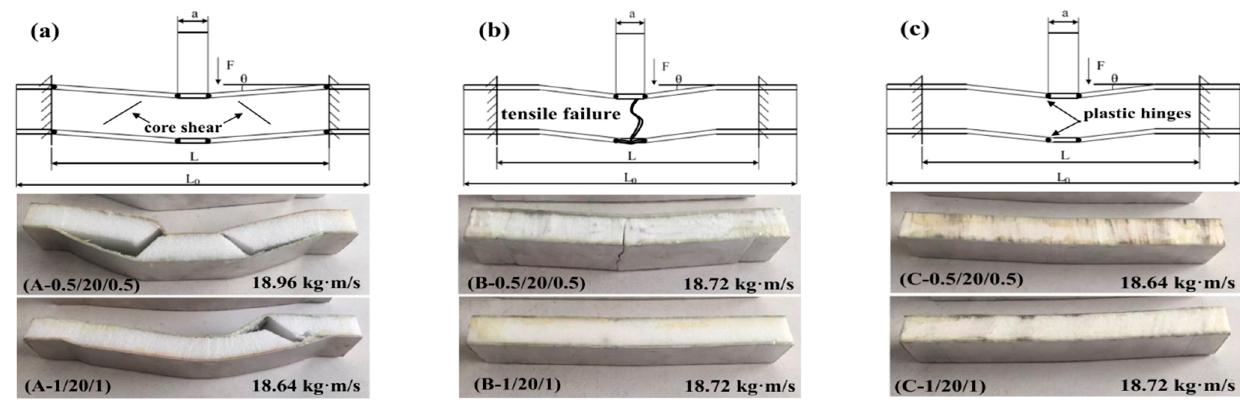
Figure 15. Failure modes and deformation mechanisms of the thick-core sandwich beams with different thickness of face sheets and different densities. ( a ) 52 kg/m 3 ; ( b ) 110 kg/m 3 ; ( c ) 200 kg/m 3 .